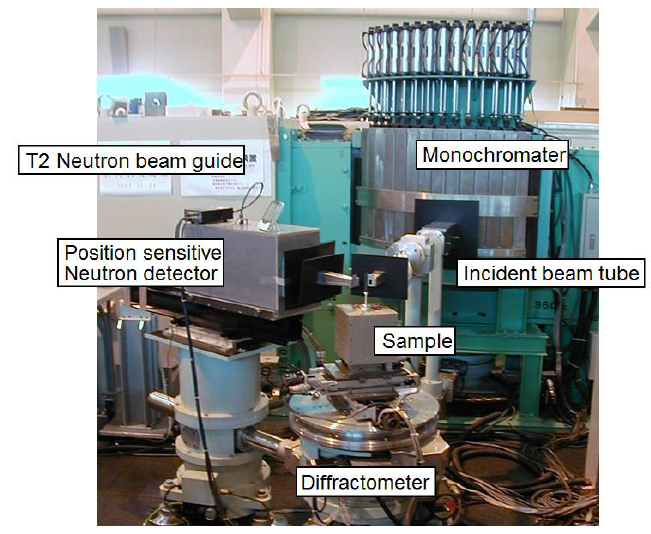
Figure 8. Appearance of RESA in JRR-3.